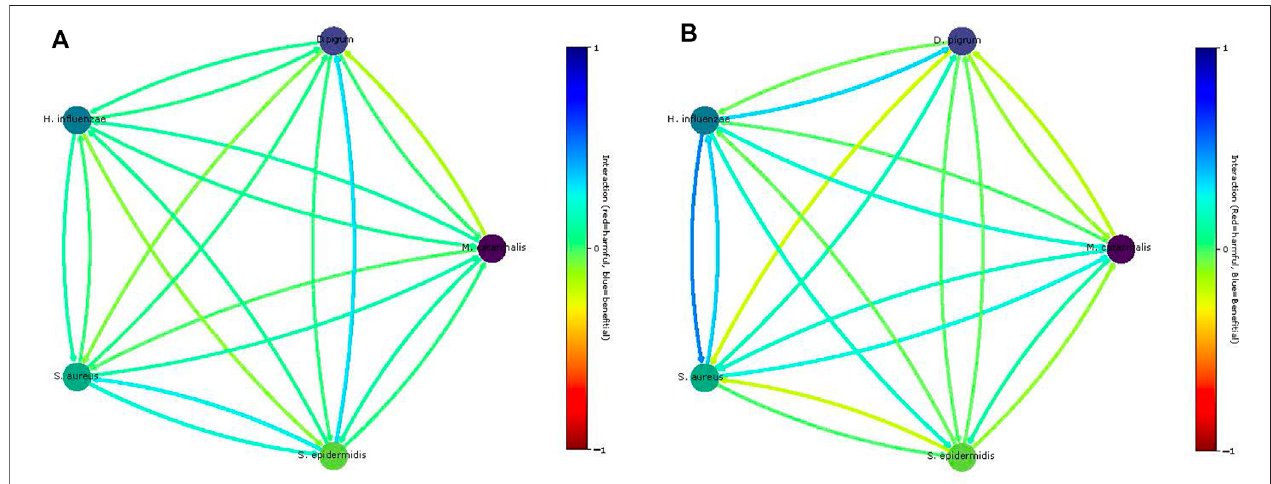
FIGURE8| Predictedcommunityinteractionswithindifferentmedia.Panel (A) showsinteractionontherichSNM3.Panel (B) showstheinteractionontheCOMPM under cooperative